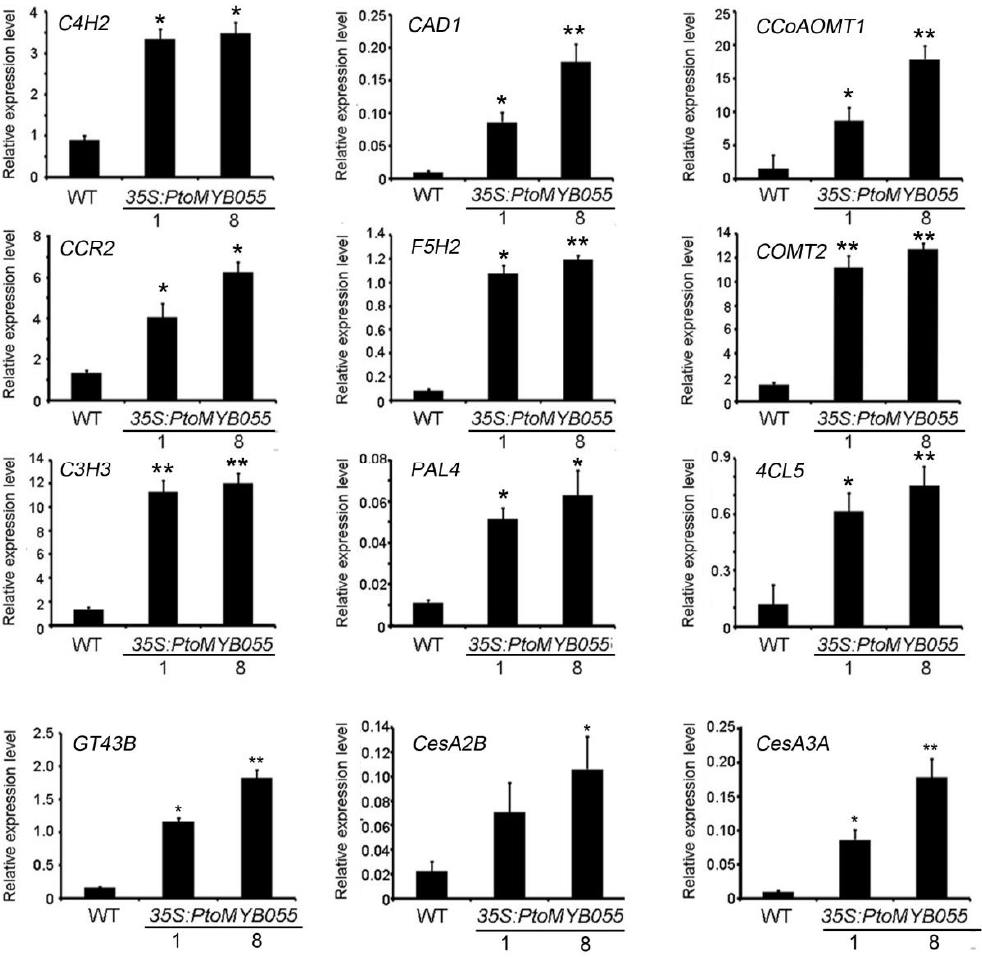
Figure 6. Gene expression analyses of secondary cell wall biosynthetic genes in 35S-PtoMYB055 poplar plants. Transcriptional expression of genes involved in lignin biosynthesis ( C4H4 , CAD1 , CCoAOMT1 , CCR2 , F5H2 , COMT2 , C3H3 , PAL4 , 4CL5 ), xylan ( GT43B ), and cellulose ( CesA2B , CesA3A ) was upregulated. The poplar Actin gene was used as an internal control. Error bars represent ± SD of three biological replicates. * p < 0.05. ** p <